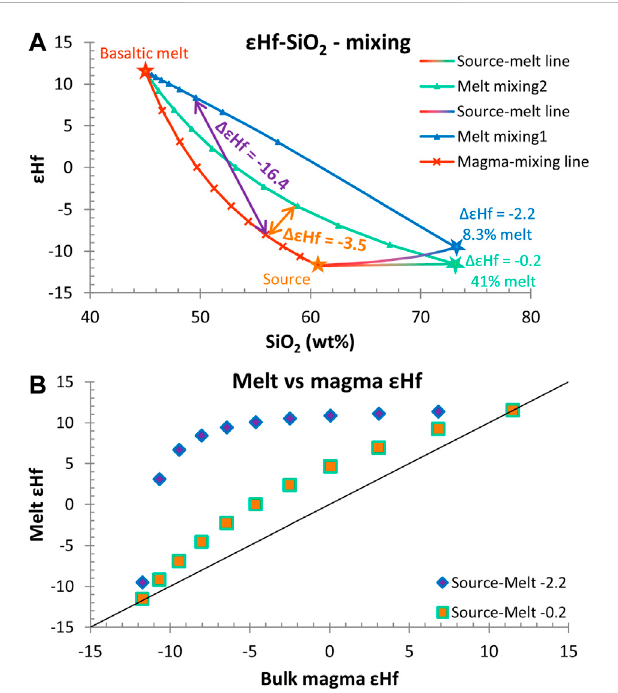
FIGURE 10 (A) The Hf isotope compositions plotted against MgO content. intermediate composition. A graph of ε Hf i versus Hf concentration (Figure 10B) hints at the presence of at least two trends. From the most ma fi c and isotopically primitive samples (A and H) a low Hf trend seems to extend through ma fi c and intermediate samples to the felsic MG and a high Hf trend seems to extend through sample L and into the other granitoids (WG, WQM and the felsic dyke). Alternatively, the low Hf samples could re fl ect an AFC trend, with the high Hf samples resulting from later fractional crystallisation of different batches along that trend.